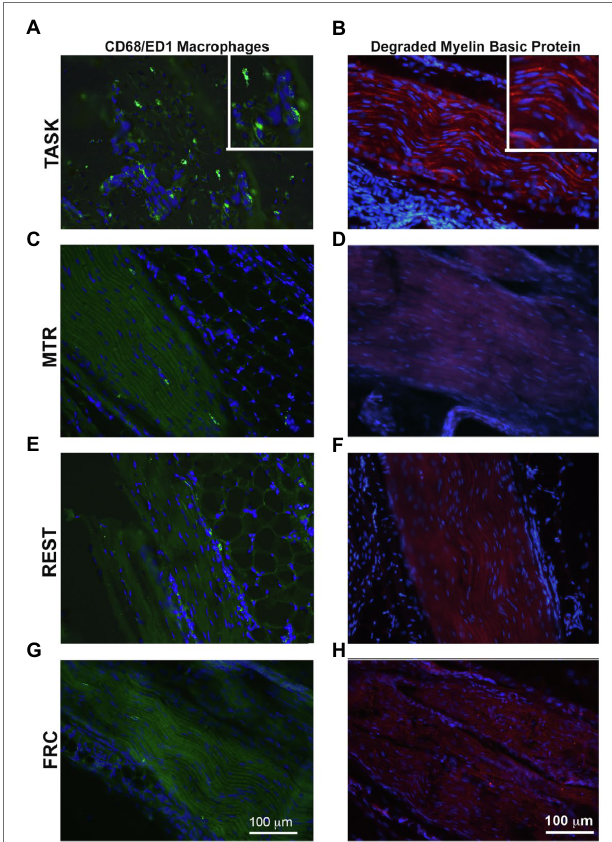
FIGURE 5 | CD68-immunopositive macrophages (green) and degraded myelin basic protein (red) in longitudinal sections of the median nerve. 4 ' ,6-diamidino-2-phenylindole (DAPI) was used as a counterstain (blue). (A,B) TASK rats. (C,D) MTR rats. (E,F) Rest rats. (G,H) FRC rats. Left panels: Representative images of CD68+ cells in median nerves at wrist level. Right panels: Representative images of degraded myelin basic protein in median nerves at wrist level. Scale bars in panels A and B = 100 μ m and applies to the other